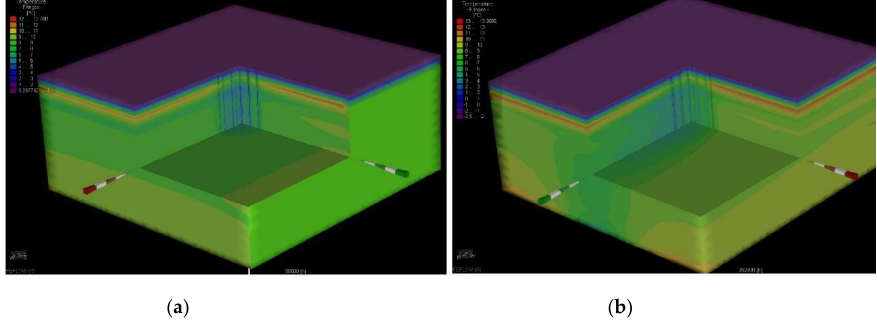
Figure 10. Results of the 3D simulation of ground temperature after 10 years ( a ) and 30 years ( b ) of heat pump operation within the 2nd scenario (homogeneous model); the view from the north-west.